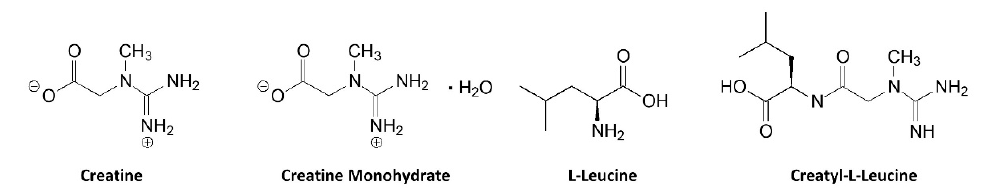
Figure 15. Comparison of creatine, creatine monohydrate, L-leucine, and creatyl-L-leucine chemical structures.